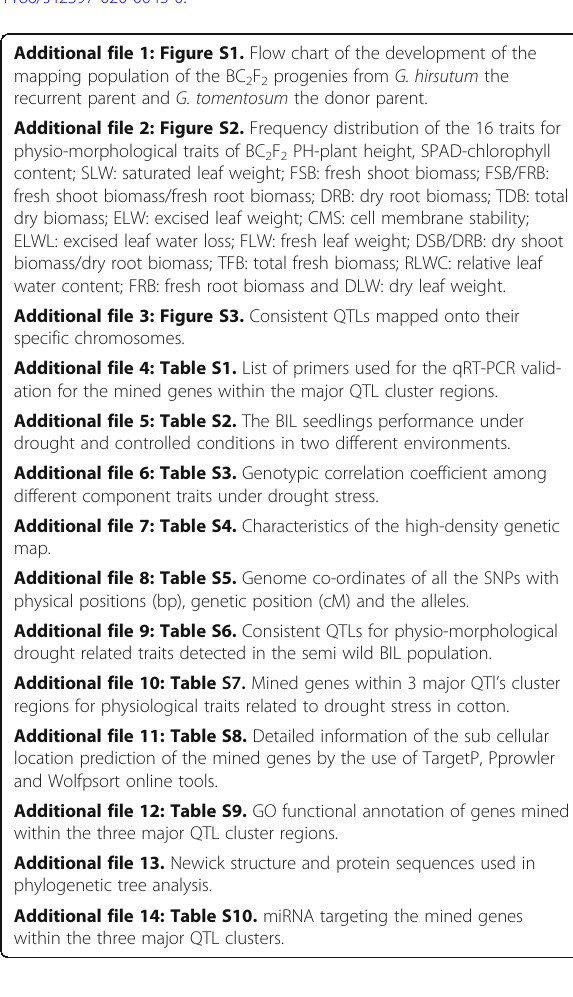
variation; QTL: Quantitative trait